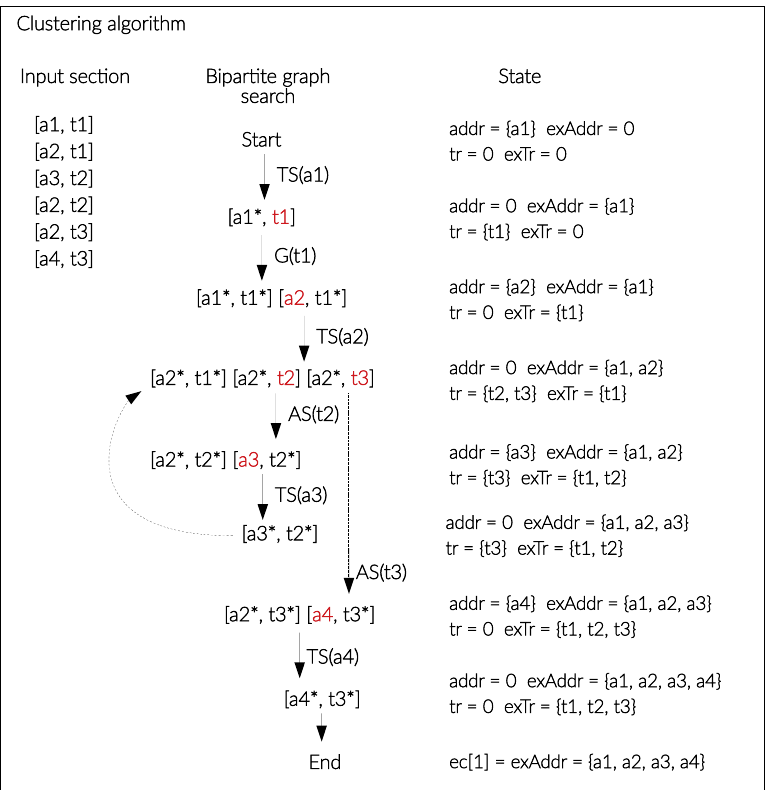
Figure 3. Graphical example of working principles of the Clustering algorithm. In this figure, the input section represents the content of the resulting table inputSection obtained after the transformation of a batch of 150 blockchain blocks. Letters a and t represent the values of the fields address and transaction hash contained in this table. The symbol TS is the transaction search algorithm (Algorithm 2), and the symbol AS is the address search algorithm (Algorithm